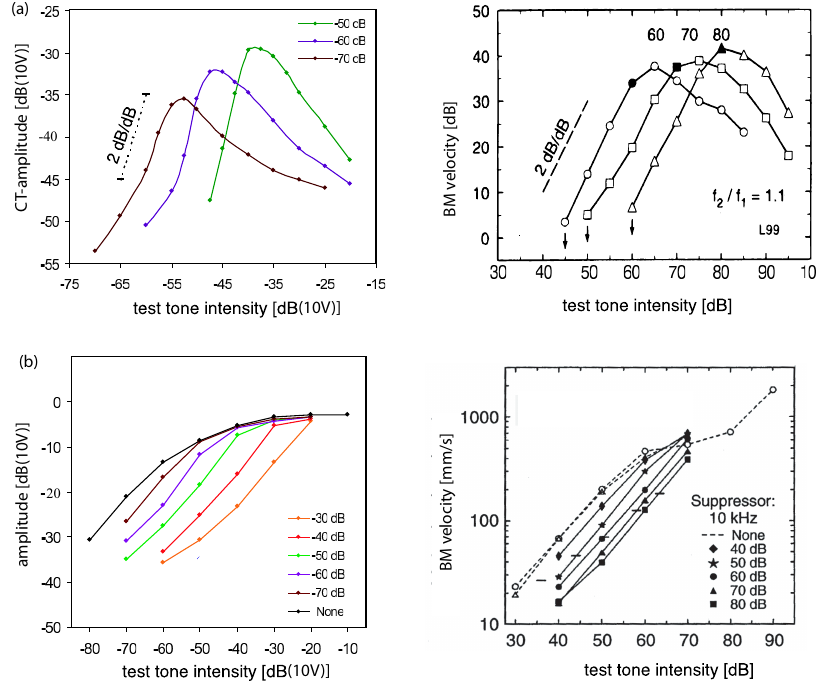
Figure 4 . Salient nonlinear phenomena of hearing: a) Combination-tone, b) two-tone suppression. Left: electronic cochlea ( µ = − 0 . 05 , central frequency: 1480 Hz), right: physiological measurements (adapted from a): [24]; b): [25]). See also [26, 27].